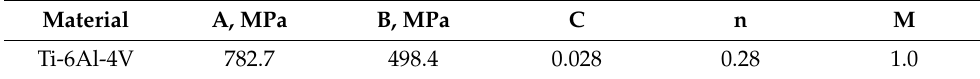
Table 1. Parameters of the material used in the simulations and experiment